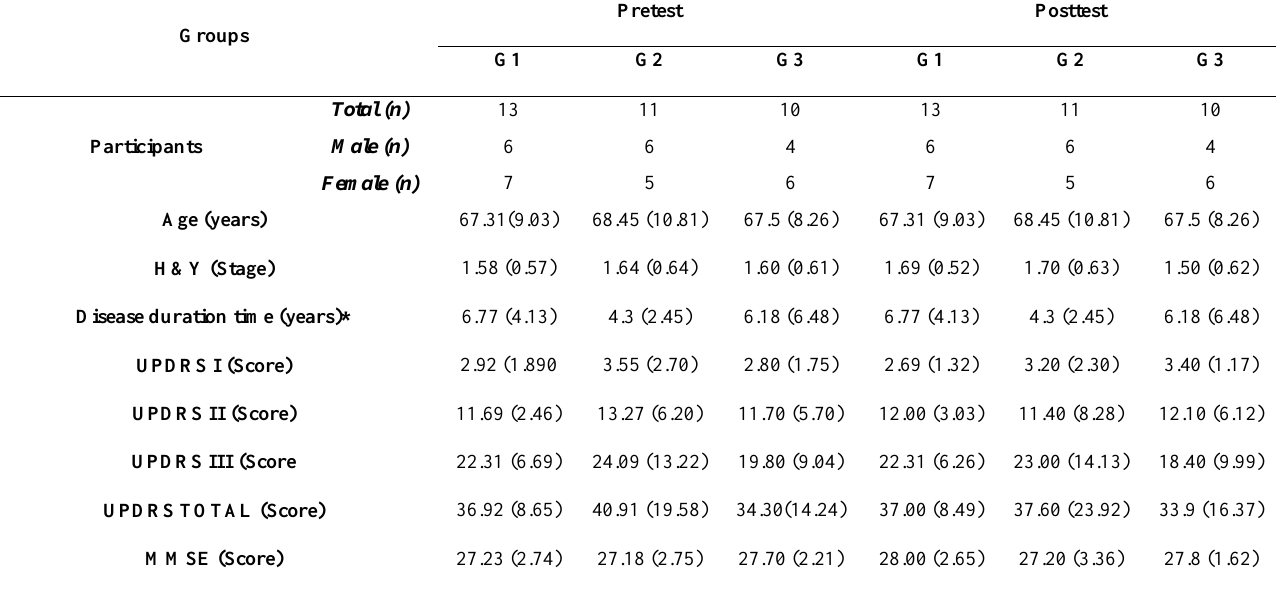
Table 1. Characteristics of the groups at baseline (pretest) and after four months of participation in each of the intervention protocols (posttest). Means (standard